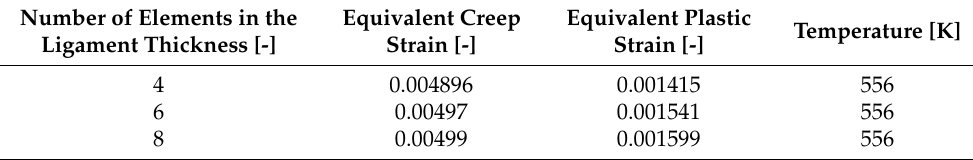
Table 8. Plastic strains, creep strains, and temperature values at the end of the hot phase. Number of Elements in the Ligament Thickness [-]